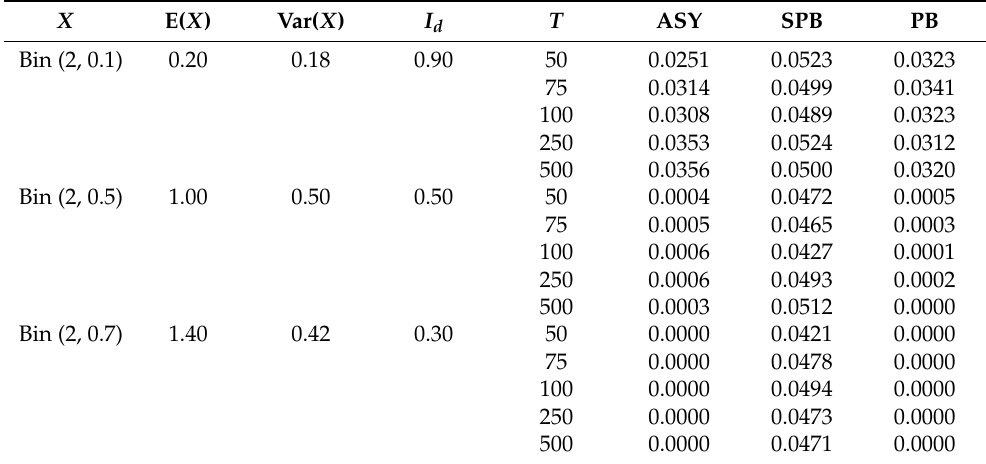
Table 3. Empirical size of the bootstrap-based score test under binomial DGP. ASY: asymptotic, SPB: semiparametric bootstrap, PB: parametric